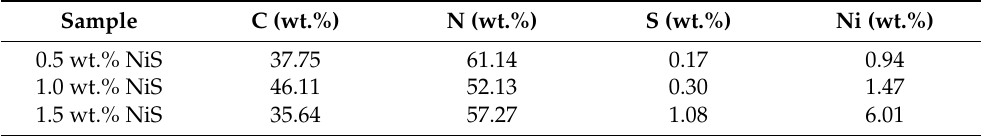
Figure 3. ESEM micrographs of S@g-C 3 N 4 and NiS-g-C 3 N 4 nanocomposites. Table 1. Weight % of elements present at the surface of the NiS-g-C 3 N 4 samples analyzed from EDX analysis.